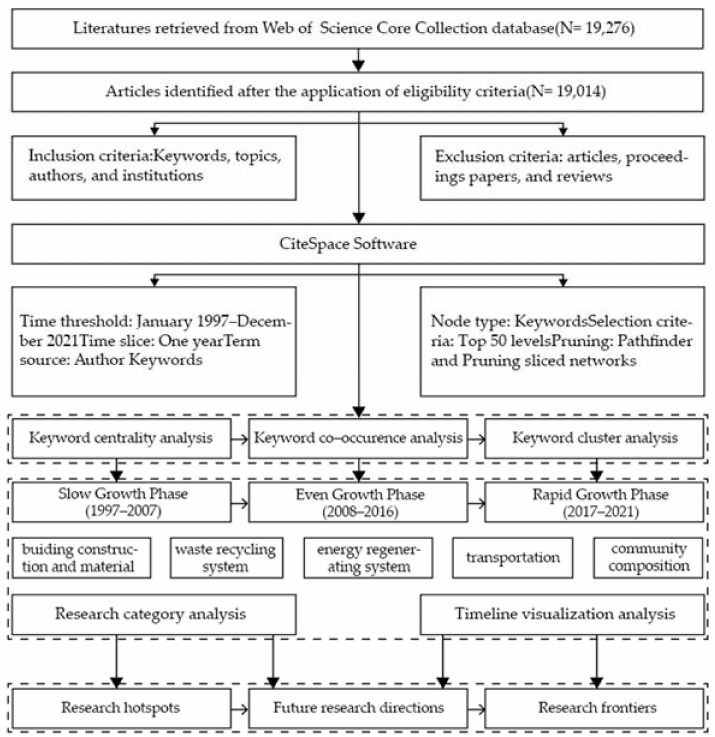
Figure 1. Outline of ZCC research design.